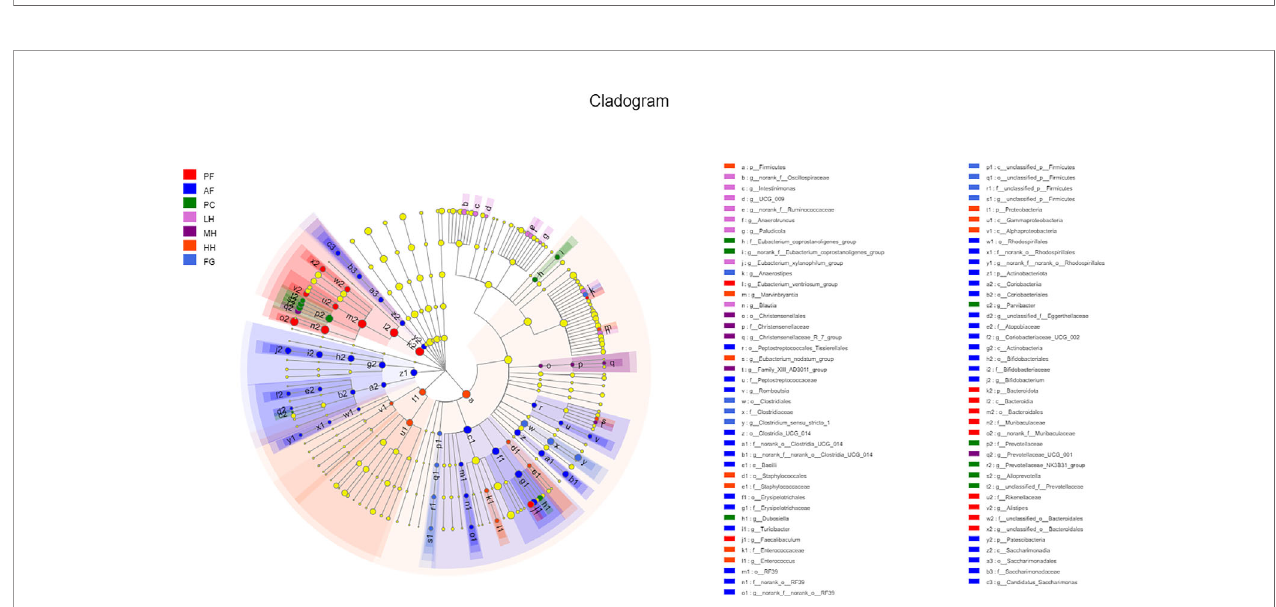
FIGURE 5 | LEfSe analyses of gut microbiota in seven groups of mice. Differentially expressed taxa with the LDA scores > 2.0 and adjusted p < 0.05. The taxonomic cladogram shows the relative abundance of OTUs with circles representing phylogenetic levels from phylum (innermost circle) to species (outermost circle) and the diameter of each circle being proportional to the taxon ’ s